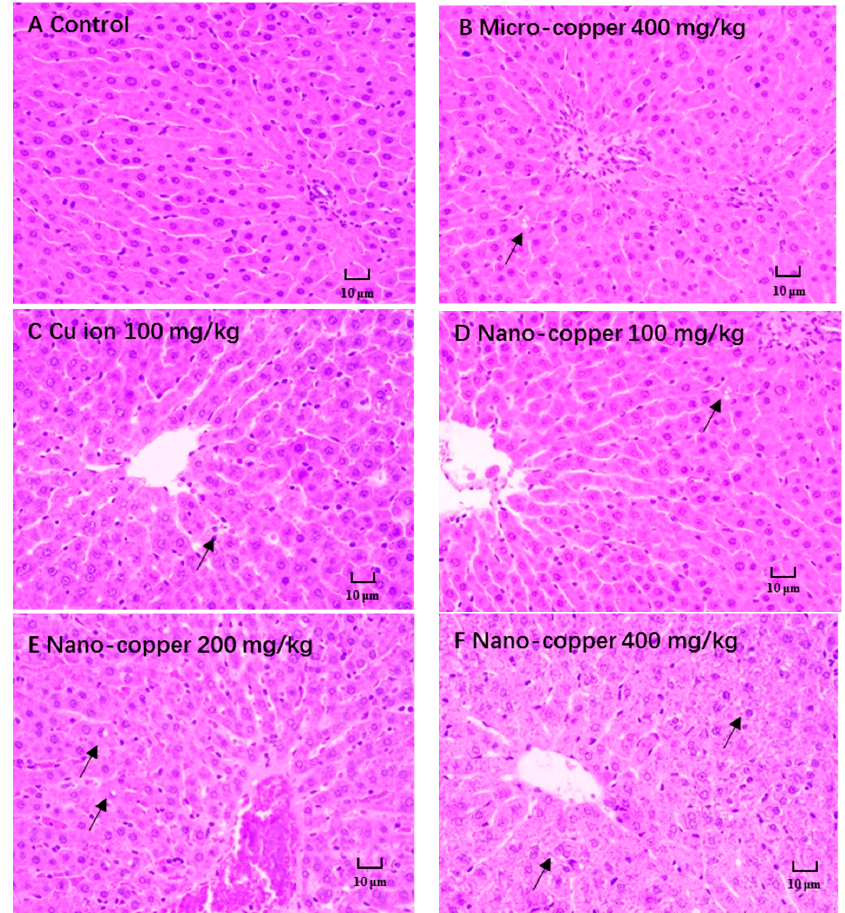
Figure 2. The histopathological changes of different copper treatments on rat liver. ( A ) Control group, ( B ) micro-copper treated group, ( C ) CuCl 2 ·2H 2 O treated group, ( D – F ) nano-copper treated group. Lesion severity ( → ) increase with increasing doses of nano-copper.